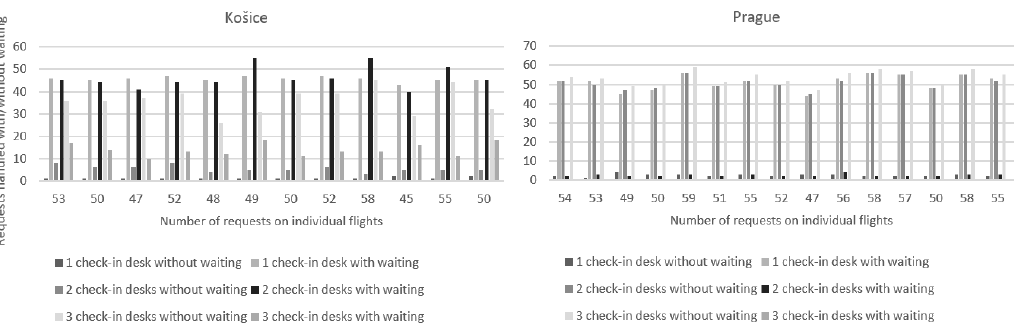
Figure 3. Comparison of the number of handled requests on flights from Košice and